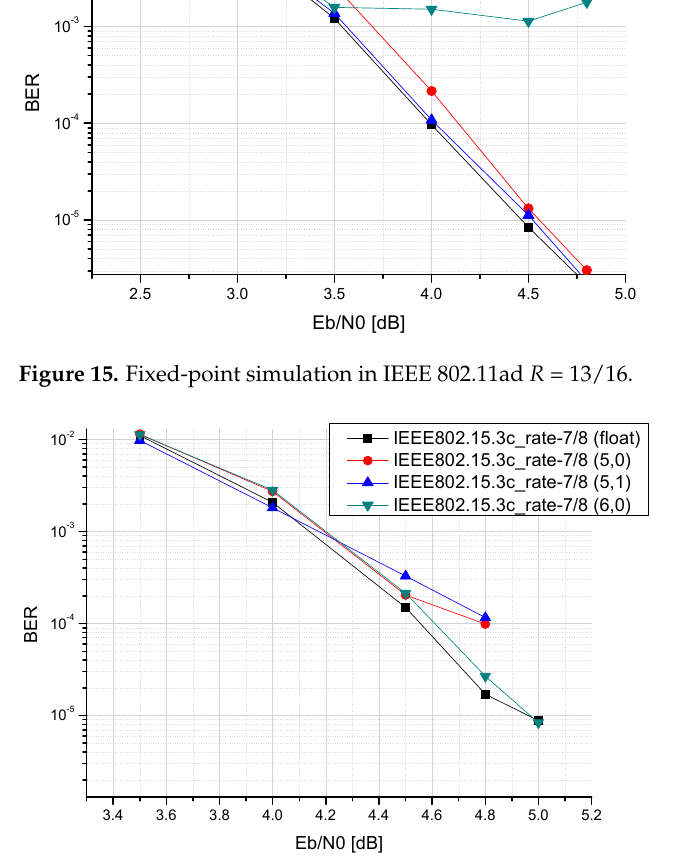
Figure 16. Fixed-point simulation in IEEE 802.15.3c R = 7/8.